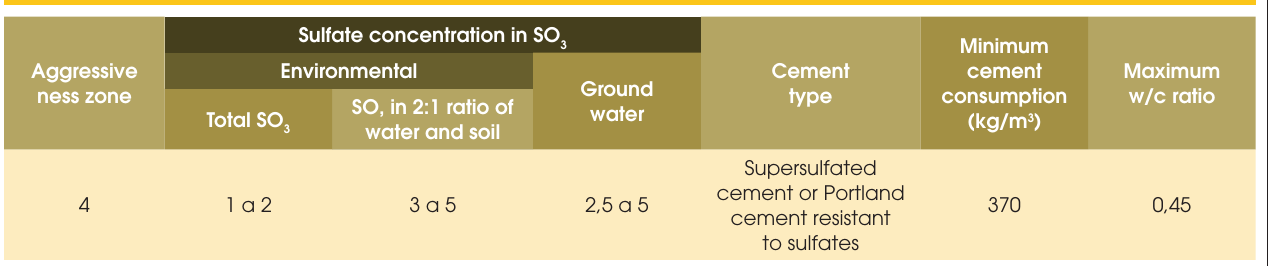
Table 6 – Recommendations for high severe aggressiveness zones